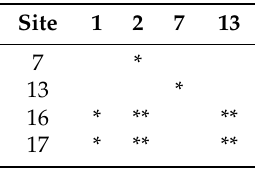
Table 4. Significant differences ( p –values) in total zooplankton species richness between examined sites. Numbers indicate site name, * p < 0.05, ** p < 0.01.